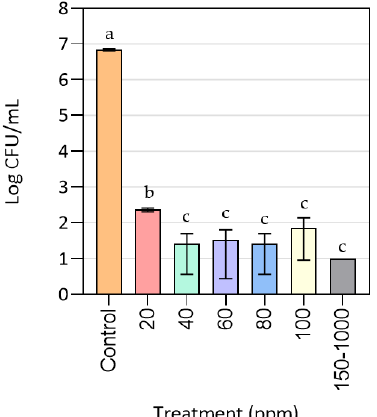
Figure 1. Antimicrobial activity of CuONPs against methicillin-resistant Staphylococcus aureus (MRSA). The 150–1000 bar represents the following concentrations: 150, 200, 300, 350, 400, 500, 600 and 1000 ppm. The detection limit was 10 CFU/mL. Mean values with different letters represent significant differences ( p < 0.05) among the samples, as determined with a one-way analysis of variance (ANOVA) and Tukey’s multiple comparison tests.